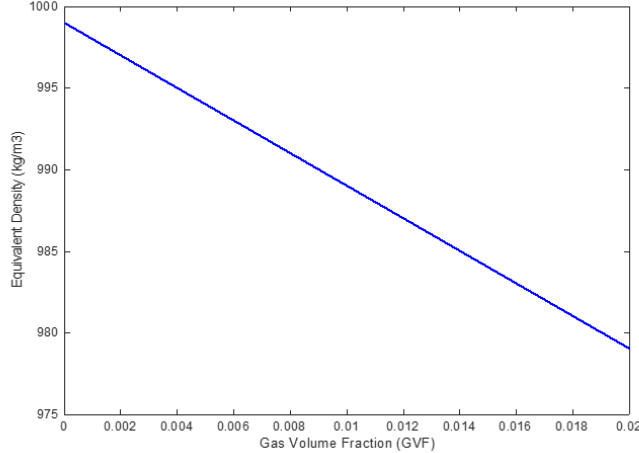
Figure 13. Equivalent fluid density.